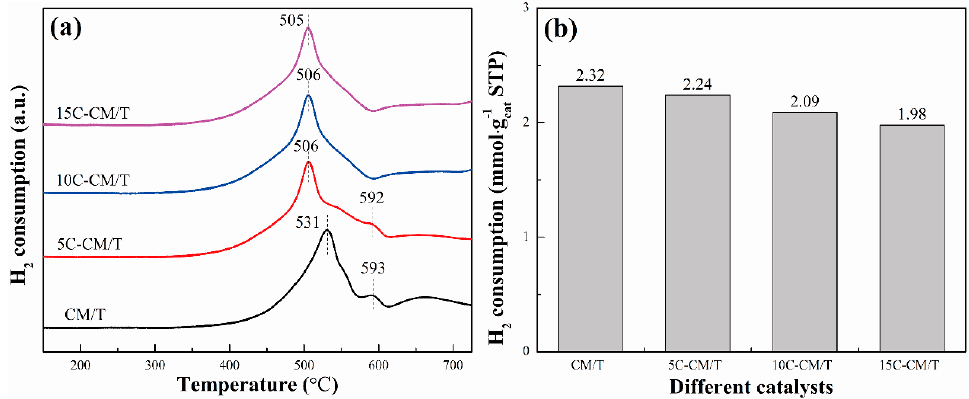
Figure 6. ( a ) NH 3 -TPD curves and ( b ) acid quantities of CM/T, 5C-CM/T, 10C-CM/T, and 15C- CM/T.